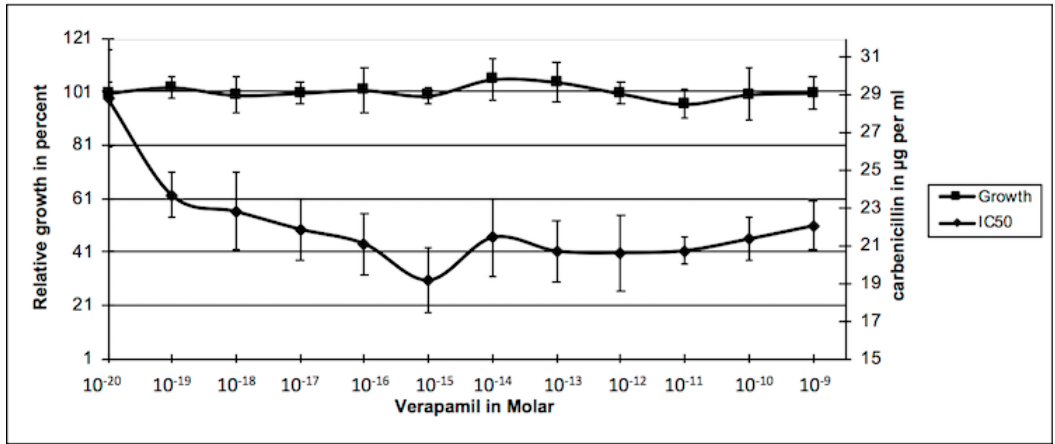
Figure 1. Effects of verapamil on P. aeruginosa growth and its sensitivity to